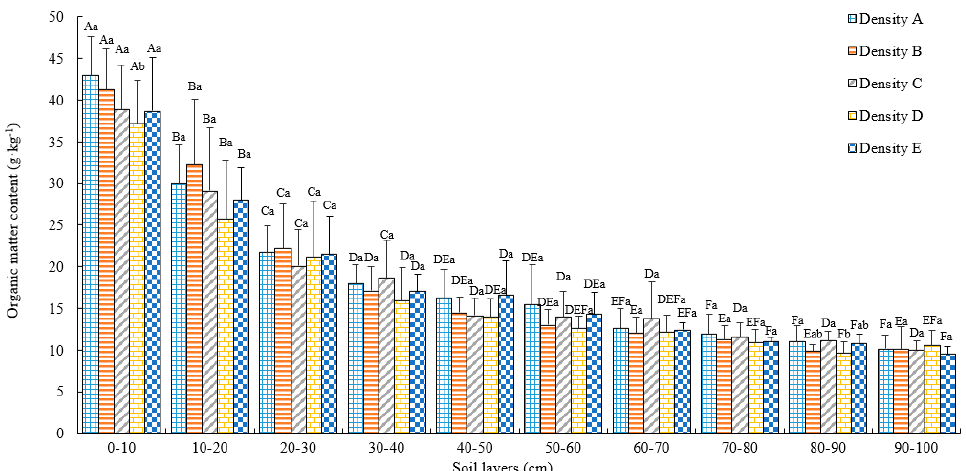
Figure 2. Soil organic matter in different layers under different stand densities (g·kg − 1 ). Note: Different lowercase letters indicate significant differences among different densities at the 0.05 level, and different capital letters for the same density indicate significant differences among different soil layers at the 0.05 level.